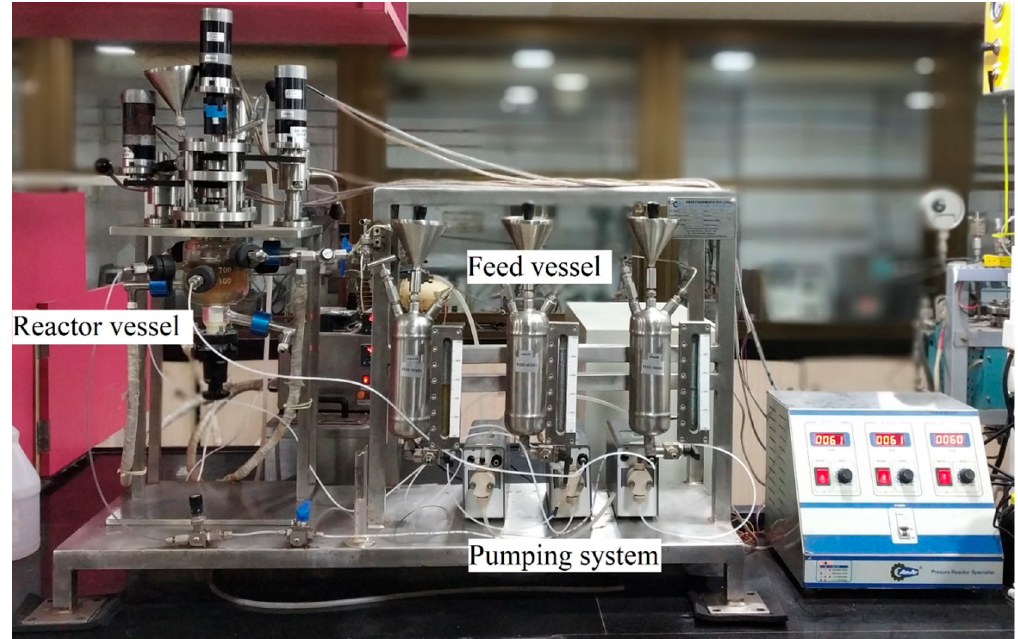
Figure 1. Front view of the actual continuous flow stirred multiphase reactor.